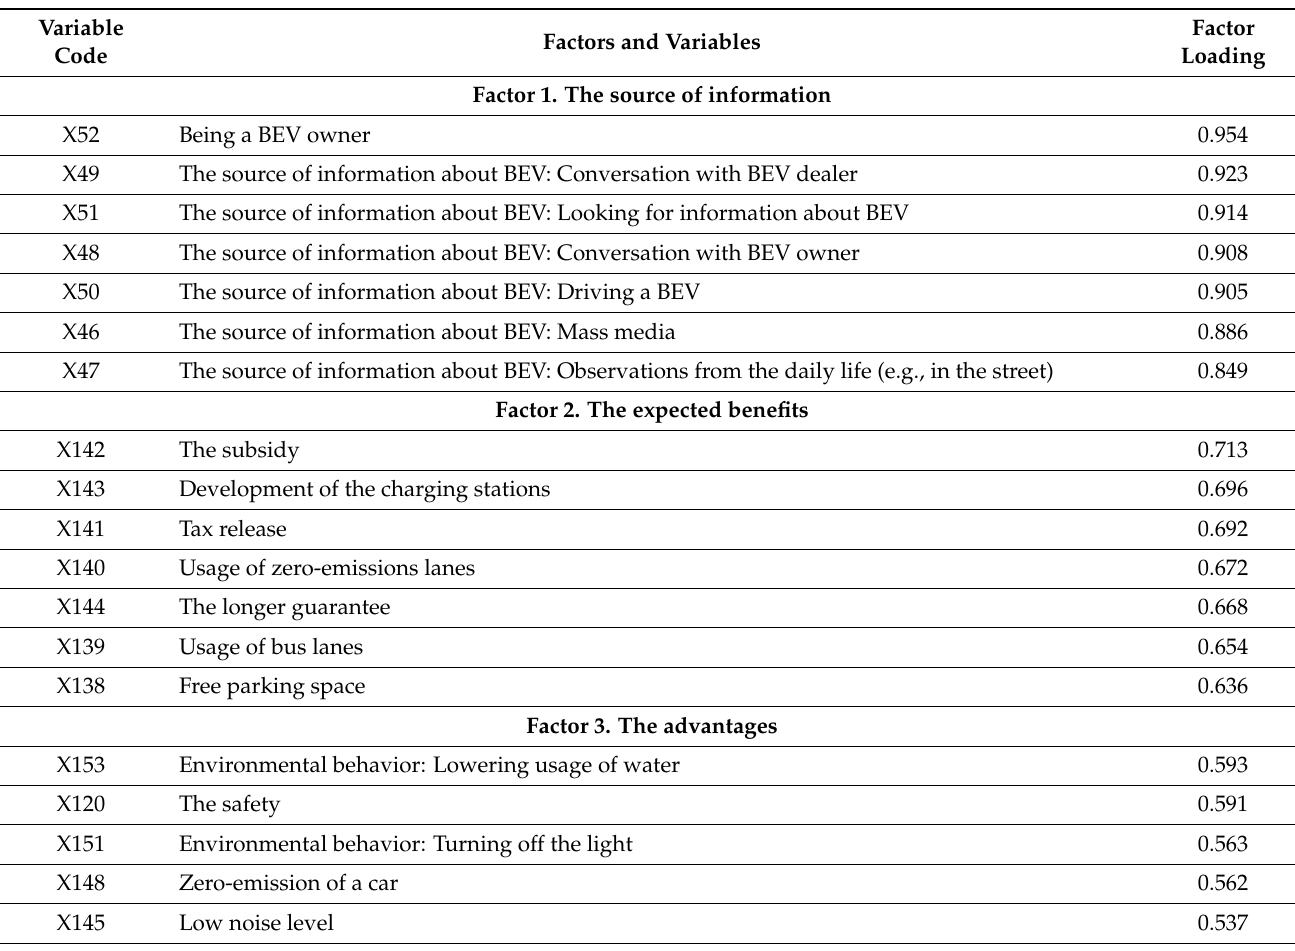
Table 5. Factors and variables included in the